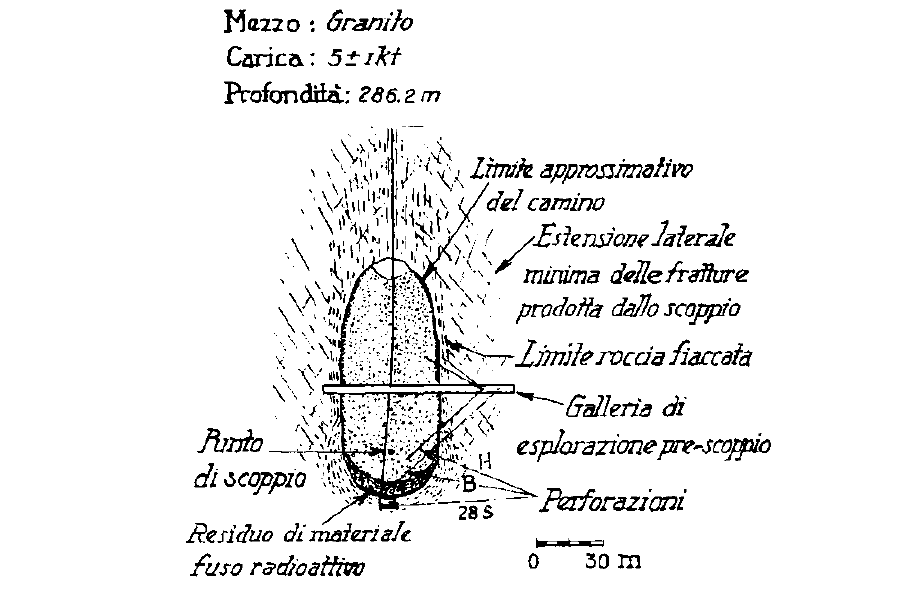
Fig. 11 - L'evento di Hardliat schematizzato nelle sue principali